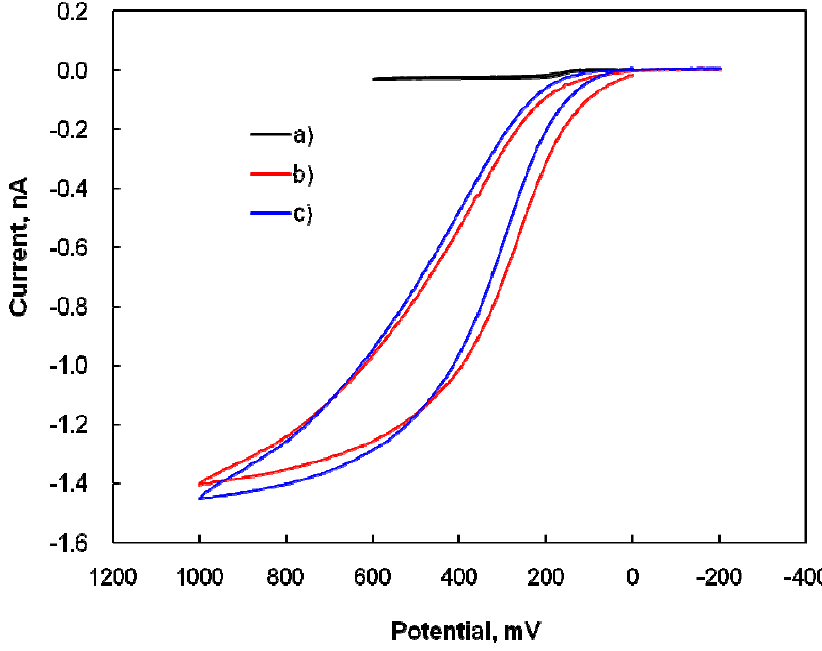
Figure 5. Cyclic voltammograms for the electrochemical response of 10  M DA (a), 1.0 mM AA (b), and the mixture of 10  M DA and 1.0 mM AA (c), at a bare CFME with a scan rate of 10